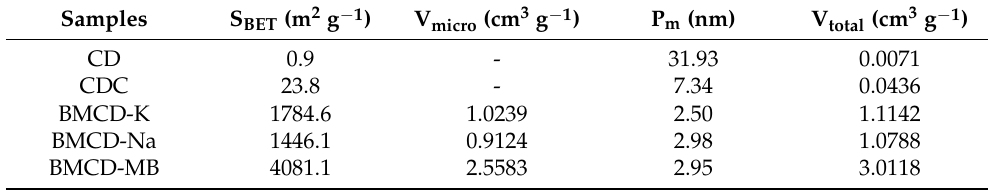
Table 1. The data of N 2 adsorption-desorption for BMCDs prepared via different activators.